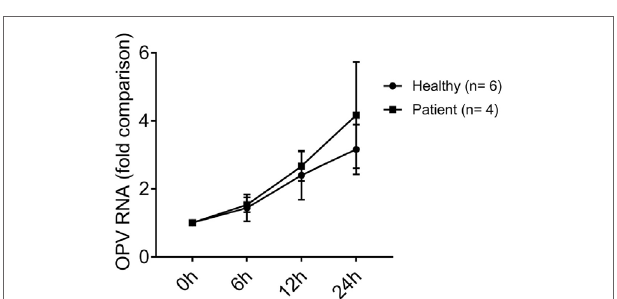
FigUre 7 | OPV RNA level in MoDCs from healthy controls and X-linked agammaglobulinemia (XLA) patients from 0 to 24 h post-infection. MoDCs from healthy controls ( n = 6) and XLA patients ( n = 4) were treated with OPV at multiplicity of infection of 1. Circles represent healthy control; squares represent patients. Fold change of viral RNA compared to 0 h post-infection was calculated by the “ ΔΔ Ct” method using beta-actin as endogenous control. Data represented as mean ± SEM.